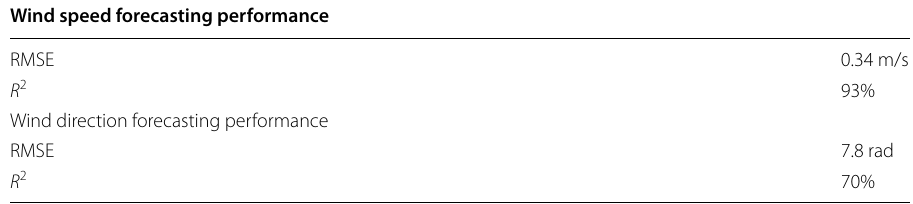
Table 5 Wind speed and wind direction forecasting